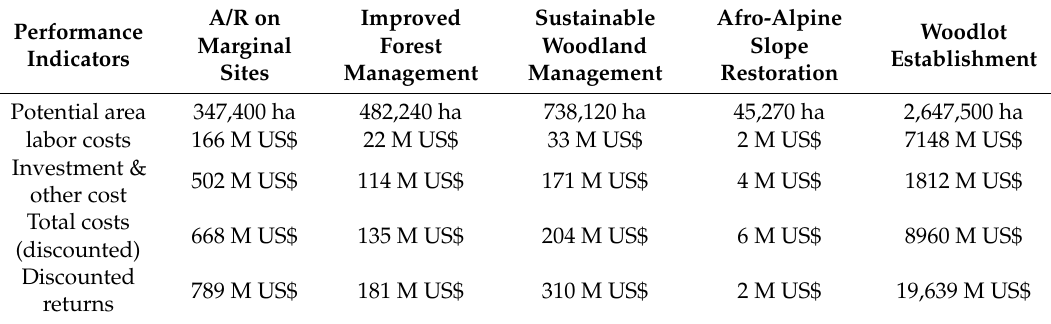
Table 3. Economic Performance indicators of identified FLR transitions (total areas)